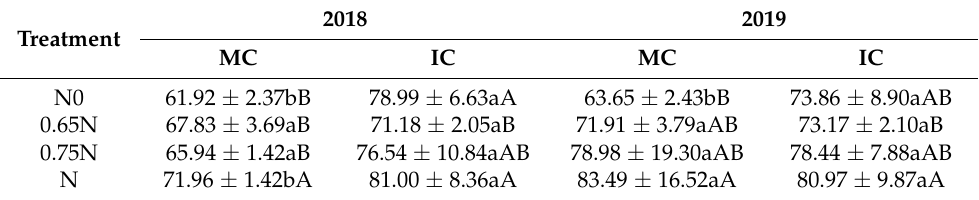
Table 5. Effects of different treatments on soil-available nitrogen content (mg kg − 1